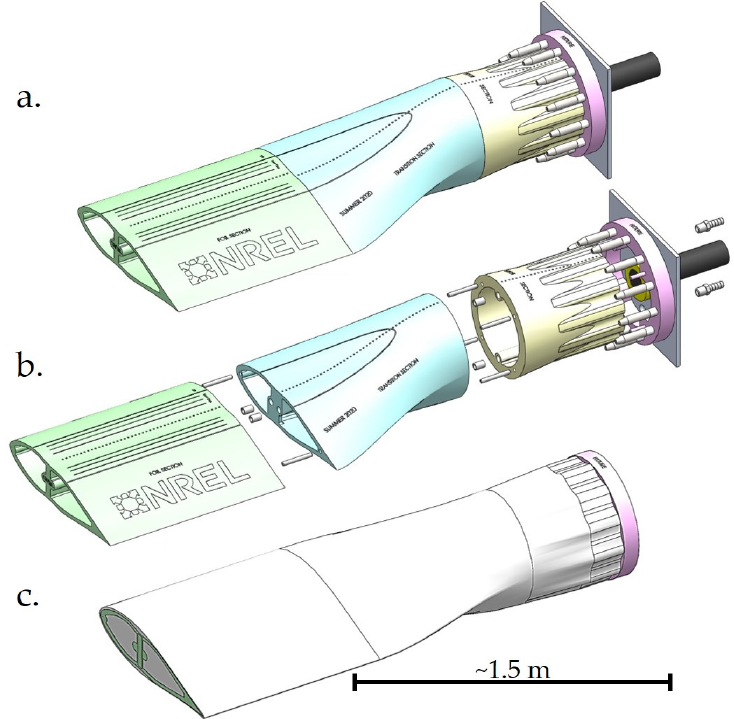
Figure 5. Full assembly drawings of the blade section mold, where ( a ) is fully assembled, ( b ) is exploded to show the connections between sections, and ( c ) includes the composite overlay.